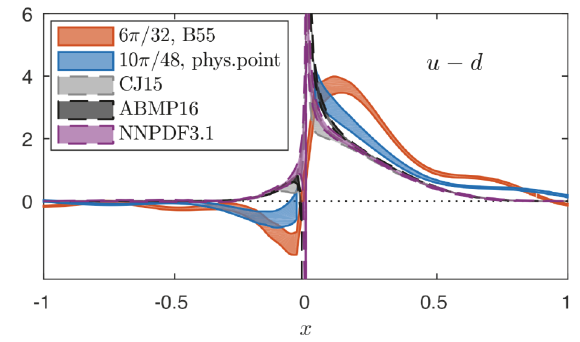
Figure 22: Comparison of ETMC’s unpolarized PDF using the ensemble at the physical point [124] (blue) and the B55 ensemble (pion mass 370 MeV) [108] (orange) at momentum ≈ 1.4 GeV. Source: [124], reprinted with permission by the Authors (article published under the terms of the Creative Commons Attribution 4.0 International